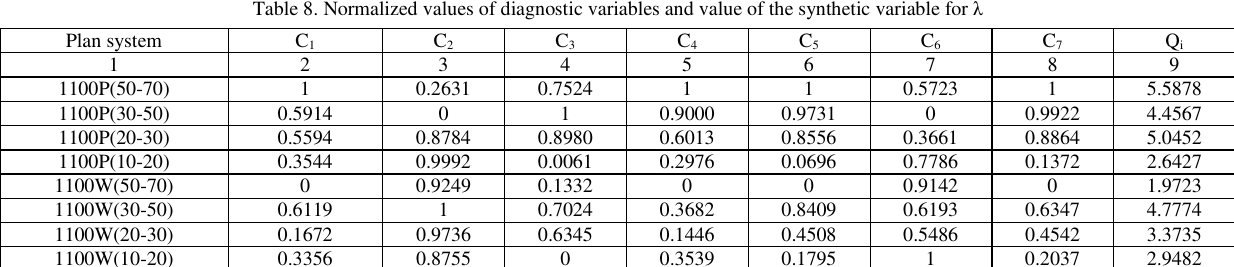
Table 8. Normalized values of diagnostic variables and value of the synthetic variable for